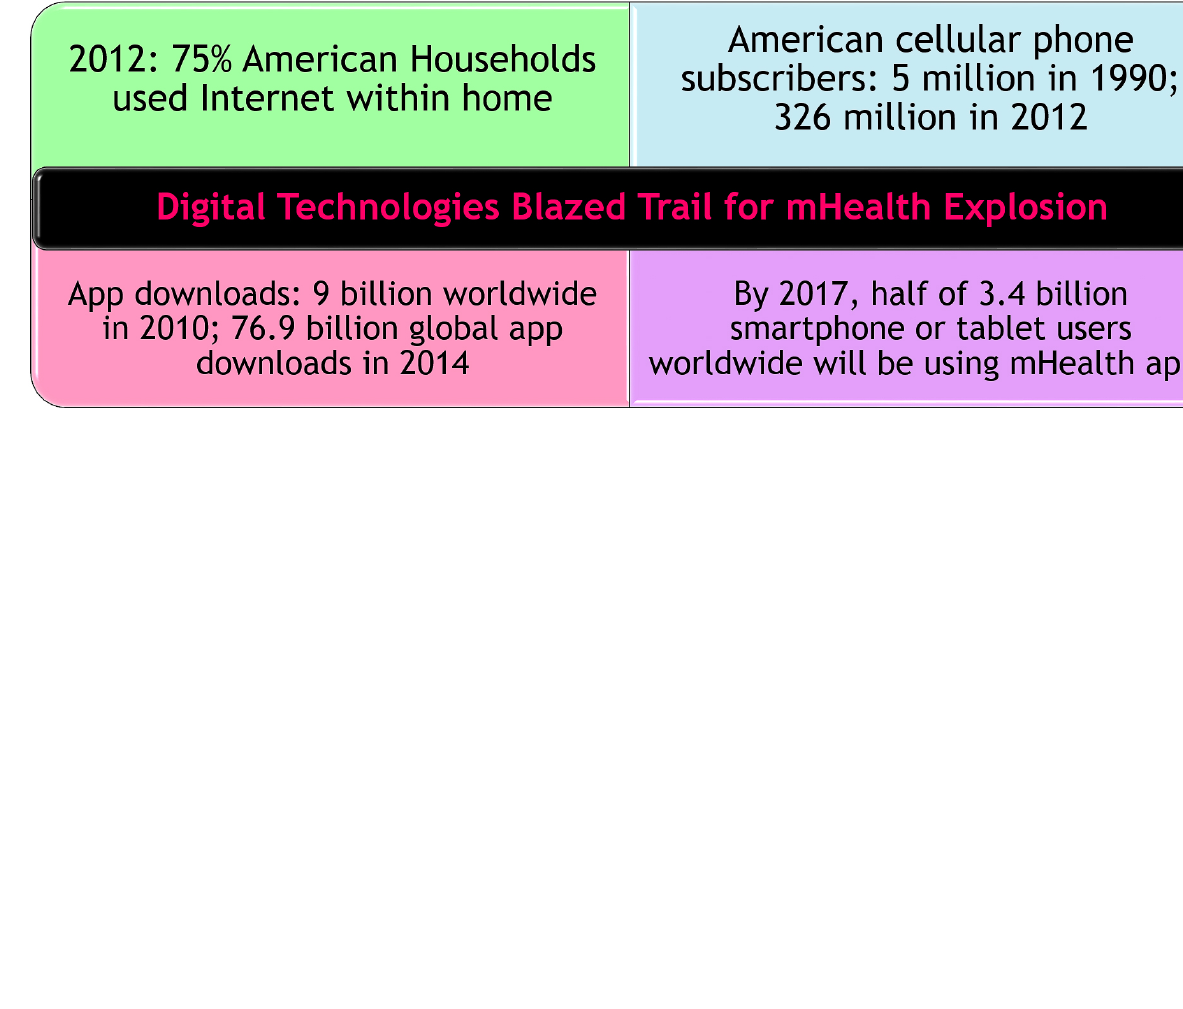
Figure 1. Digital technologies blazed the trail for the mHealth